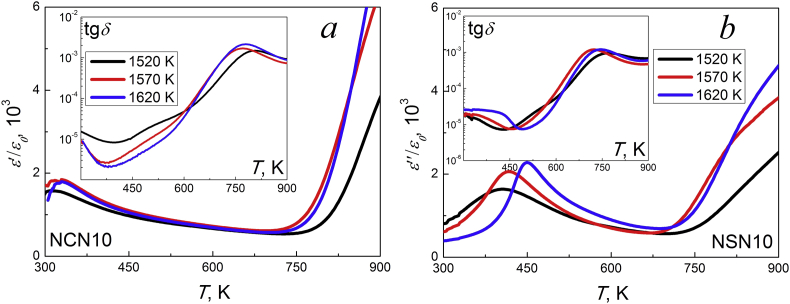
Temperature dependences of ε'/ε0 and tgδ at 100 kHz of the NCN10 (a) and NSN10 (b) ceramics obtained at various TSin.